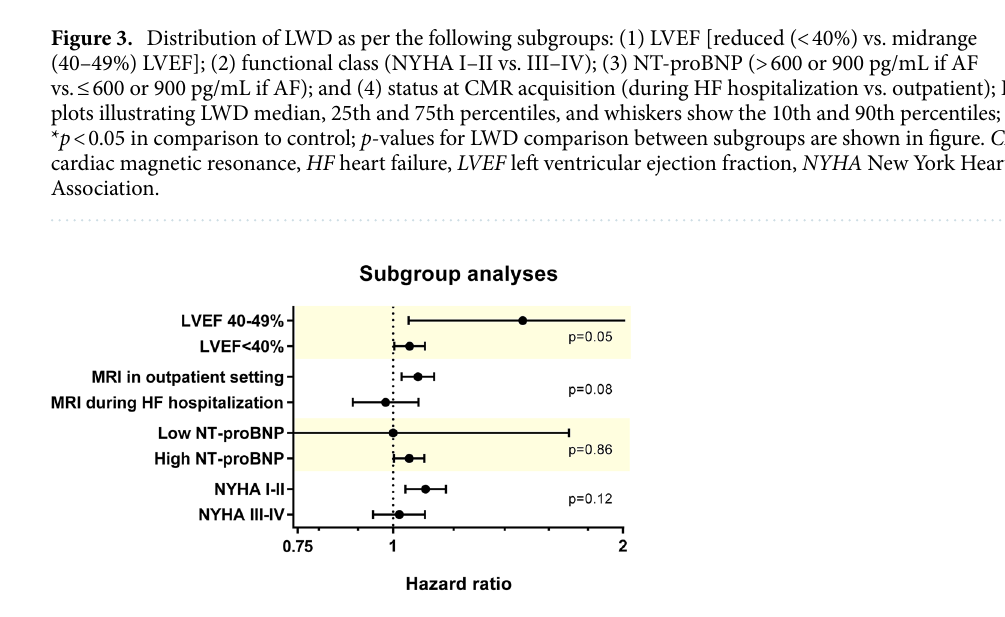
Figure 4. Primary composite endpoint analysis truncated at 1-year as per the following subgroups: (1) LVEF [reduced (< 40%) vs. midrange (40–49%) LVEF]; (2) functional class (NYHA I–II vs. III–IV); (3) NT-proBNP (> 600 or 900 pg/mL if AF vs. ≤ 600 or 900 pg/mL if AF, which is illustrated above as high vs. low NT-proBNP, respectively); and (4) and status at CMR acquisition (during HF hospitalization vs. outpatient). The HR (and 95% CI) of increased LWD (> 21.2%) for the primary endpoint is illustrated, adjusted to the variables used in the multivariate model (LVEF, serum creatinine, NT-proBNP and NYHA class). The results are consistent across different subgroups, particularly powerful in patients with LVEF 40–49% or whose MRI was performed in the outpatient setting. CMR cardiac magnetic resonance, LVEF left ventricular ejection fraction, NYHA New York Heart